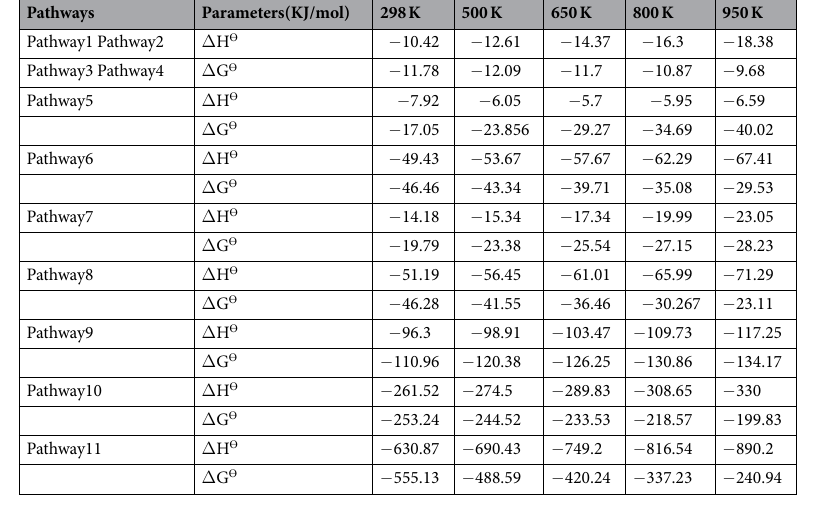
Table 8. Changes in standard thermodynamic parameters at different